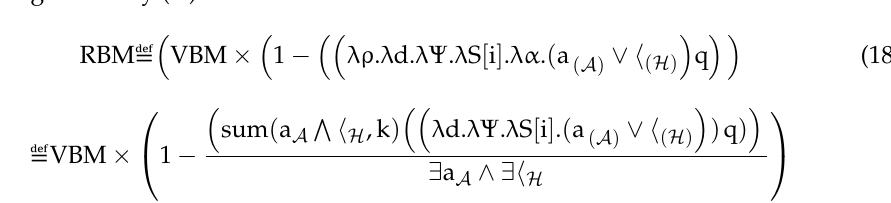
Table 3 defines a formal representation of trust-based SOA-IoT by using HOL sym- bols and interaction ways between IoT entities.